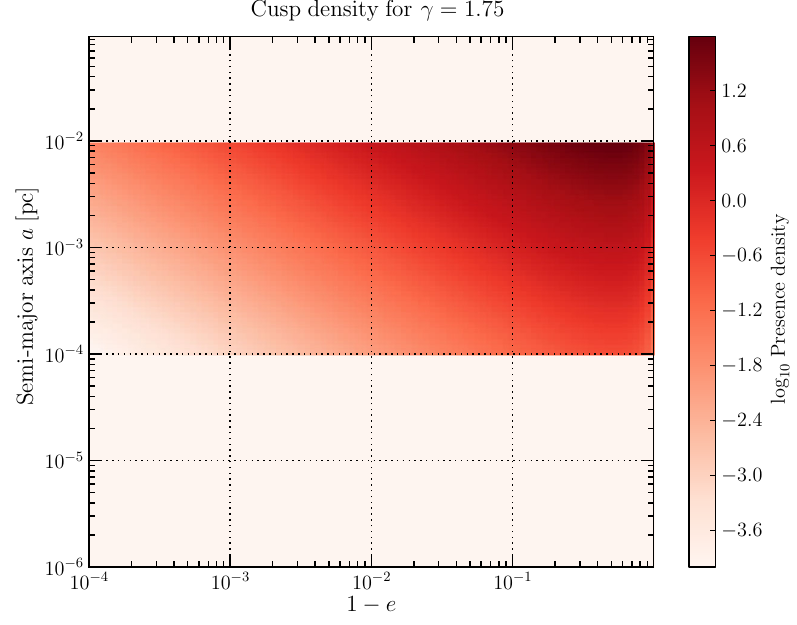
Fig. 55 Theoretical distribution for the density of presence of a cusp of power-law 1.75 around a MBH, using a truncated